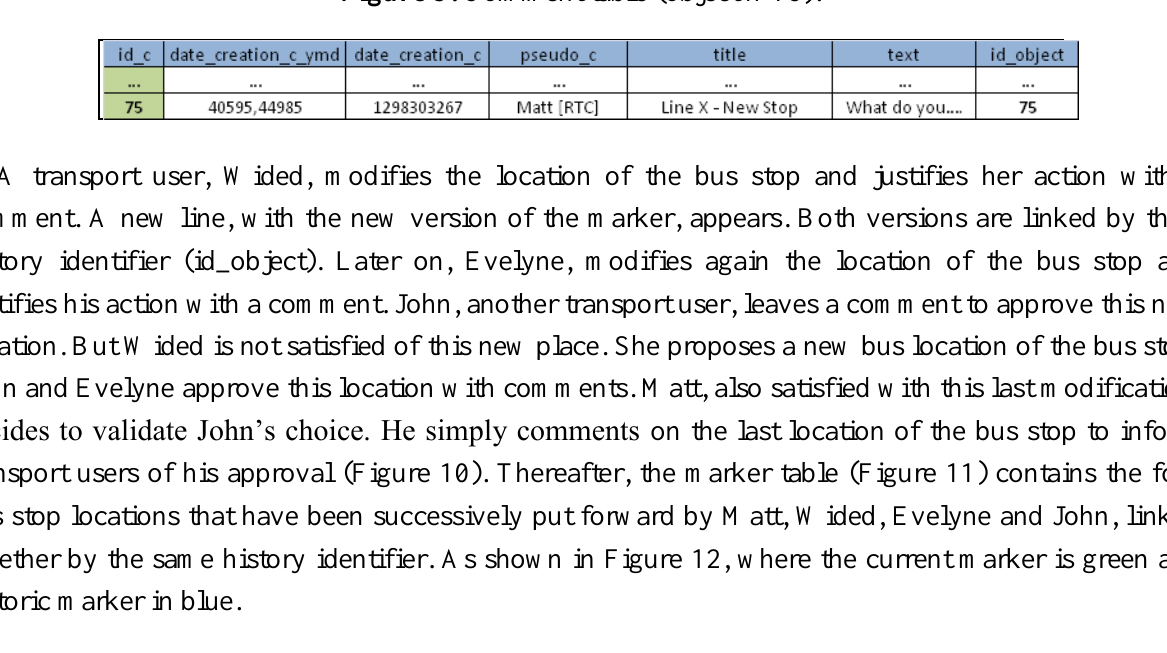
Figure 9. Comment table (object n°75).